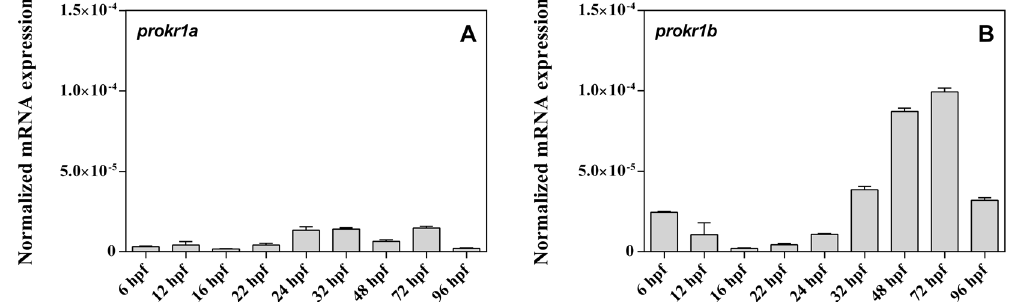
Figure 1. Real-time-PCR experiments show that during GnRH3 neuron development prokr1a ( A ) is less expressed compared to prokr1b ( B ). (gene were normalized using eef1a as housekeeping gene. For each developmental stage n =